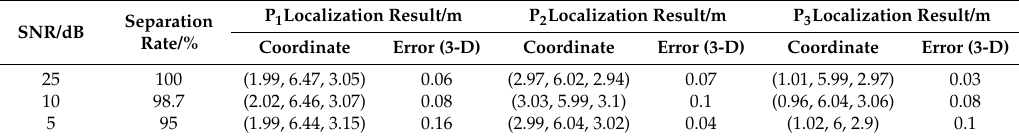
Table 4. The separation and localization results by the proposed method with different SNRs. Table 5. The separation and localization results using previously reported method at different SNRs.